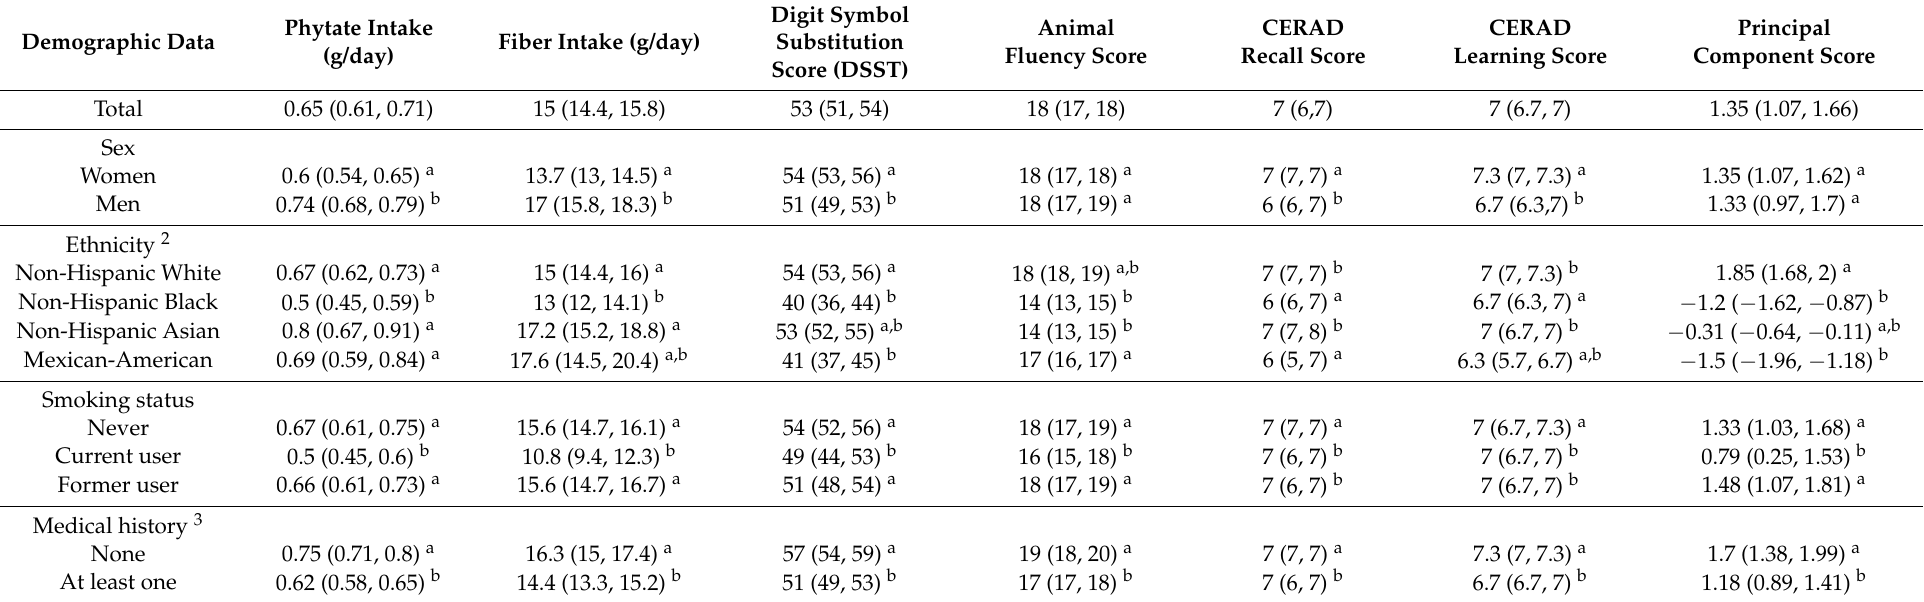
Table 2. Phytate intake, fiber intake, cognitive function and principal component scores (from cognitive function) of adults 60 years and above, NHANES 2013–2014 1